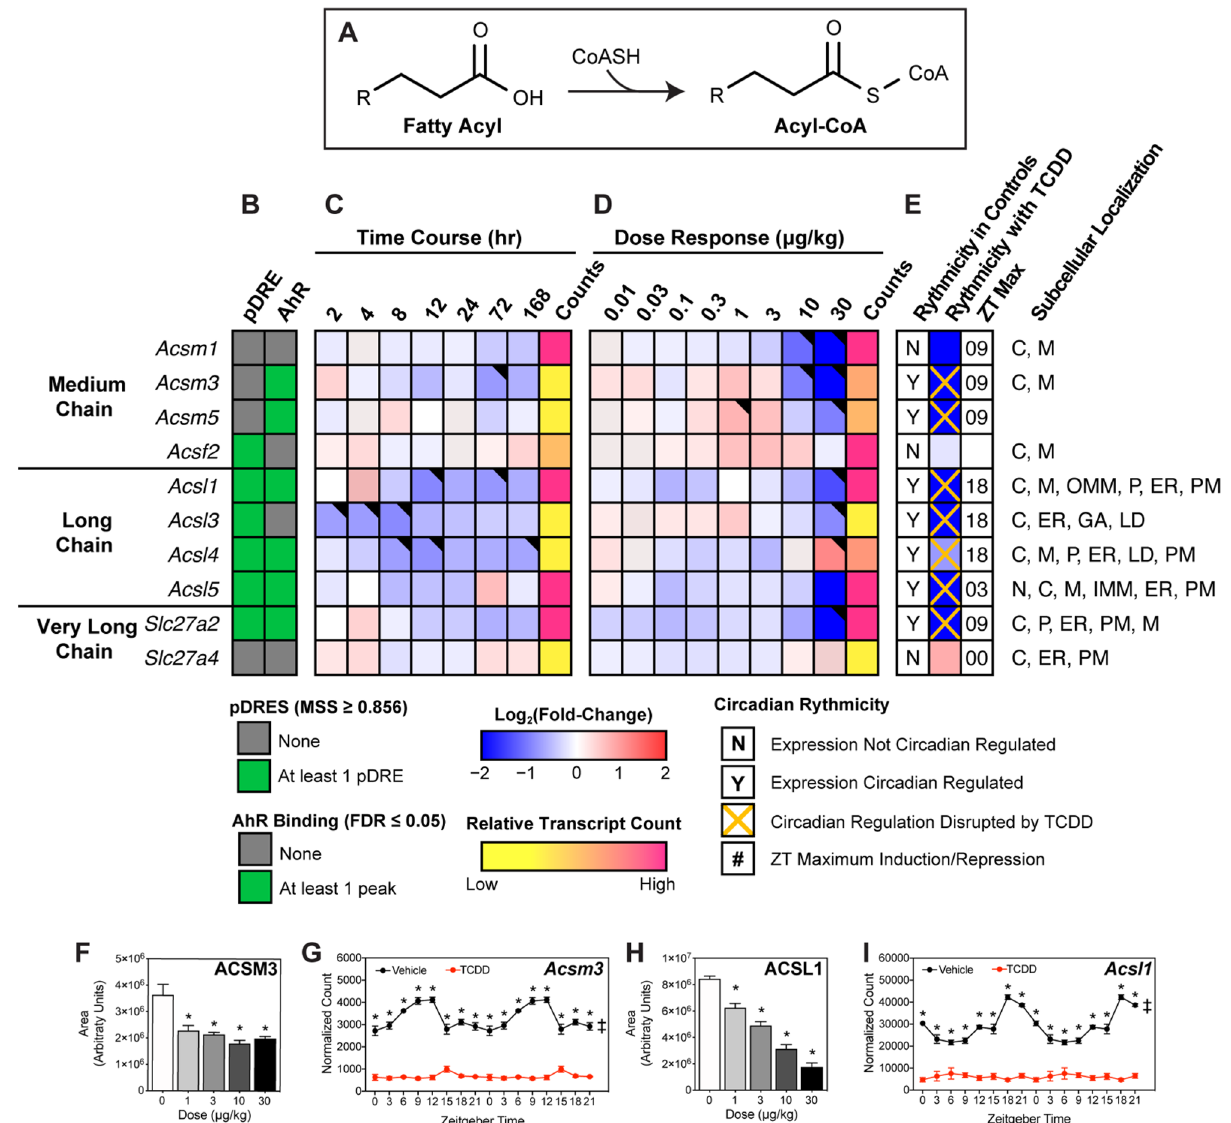
Figure 3. Effect of TCDD on hepatic fatty acid activation. Differential expression of genes associated with fatty acid activation assessed using RNA-seq. ( A ) Fatty acid activation reaction catalyzed via acyl-CoA synthetases. Official gene symbol designated in the MGI database are listed. ( B ) The presence of putative dioxin response elements (pDREs) and AhR enrichment at 2 h. ( C ) Time-dependent gene expression was assessed following a single bolus dose of 30 μg/kg TCDD (n = 3). ( D ) Dose-dependent gene expression following oral gavaged every 4 days for 28 days with 0.01, 0.03, 0.1, 0.3, 1, 3, 10 or 30 μg/kg TCDD (n = 3). ( E ) Circadian regulated genes are denoted with a “Y”. An orange ‘X’ indicates abolished diurnal rhythm following oral gavage with 30 μg/kg TCDD every 4 days for 28 days. ZT indicates statistically significant (P1( t ) > 0.8) time of maximum gene induction/repression. Counts represent the maximum number of raw aligned reads for any treatment group. Low counts (< 500 reads) are denoted in yellow with high counts (> 10,000) in pink. Differential expression with a posterior probability (P1( t )) > 0.80 is indicated with a black triangle in the top right tile corner. Protein subcellular locations were obtained from COMPARTMENTS and abbreviated as: cytosol (C), endoplasmic reticulum (ER), Golgi apparatus (GA), lipid droplet (LD), lysosome (L), mitochondrion (M), outer mitochondrial membrane (OMM), inner mitochondrial membrane (IMM), nucleus (N), peroxisome (P), and plasma membrane (PM). Capillary electrophoresis was used to assess ( F ) ACSM3 and ( H ) ACSL1 protein levels in total lysate prepared from liver samples harvested between ZT0-3 (n = 3). Bar graphs denote the mean ± SEM. Statistical significance (*p ≤ 0.05) was determined using a one-way ANOVA followed by Dunnett’s post-hoc analysis. Diurnal expression of ( G ) Acsm3 and ( I ) Acsl1 was assessed by RNA-seq (n = 3). Asterisks denotes a posterior probability (P1( t ) > 0.8) within the same timepoint comparing vehicle to TCDD. Diurnal rhythmicity (‡) was determined using JTK_CYCLE for each treatment. Circadian data are plotted twice along the x-axis to better visualize the gene expression rhythmicity. The heatmap was created using R (v4.0.4). Plots were created using GraphPad Prism (v8.4.3). The biochemical reaction was created using Adobe Illustrator